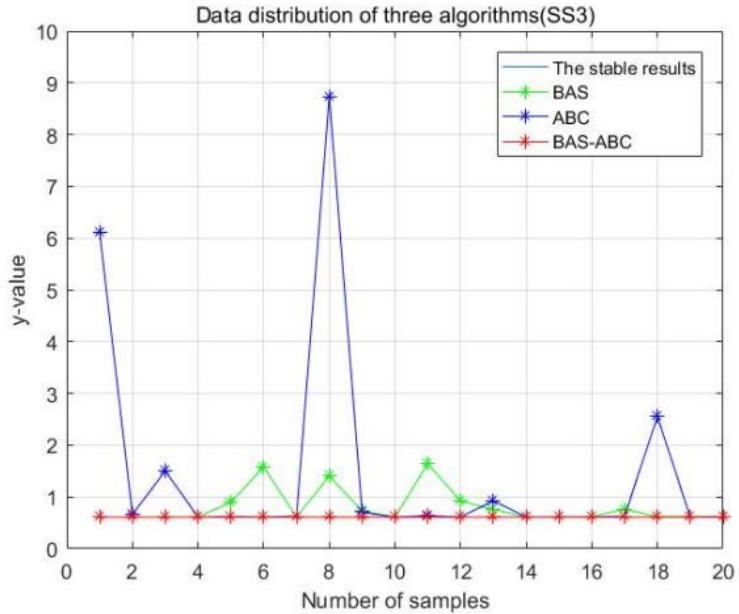
Figure 14. Data distribution-20 of three algorithms (SS3).